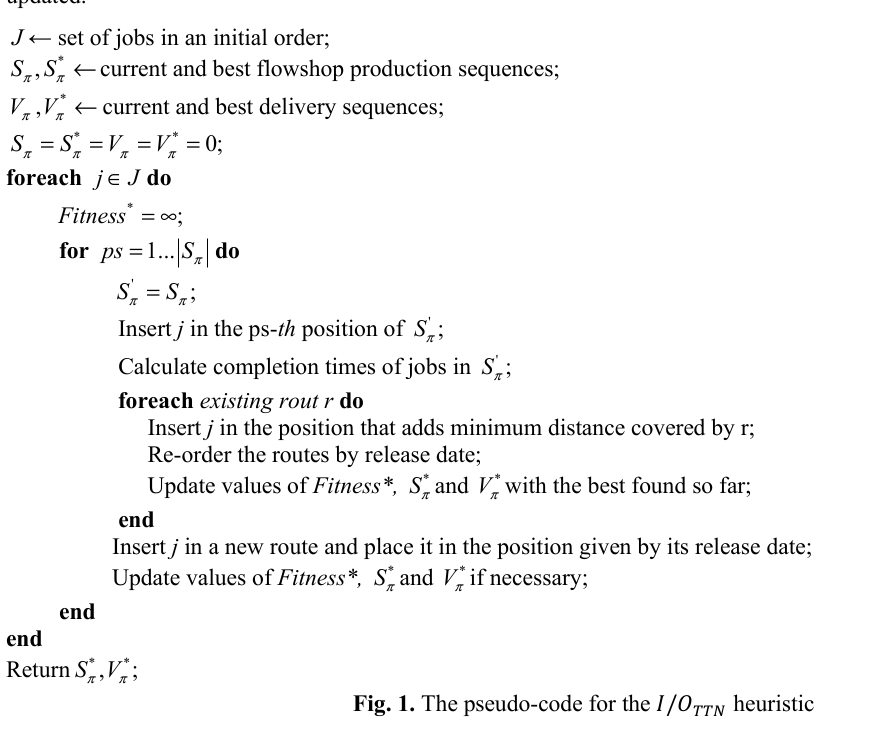
Fig. 1. The pseudo-code for the 𝐼 / 𝑂